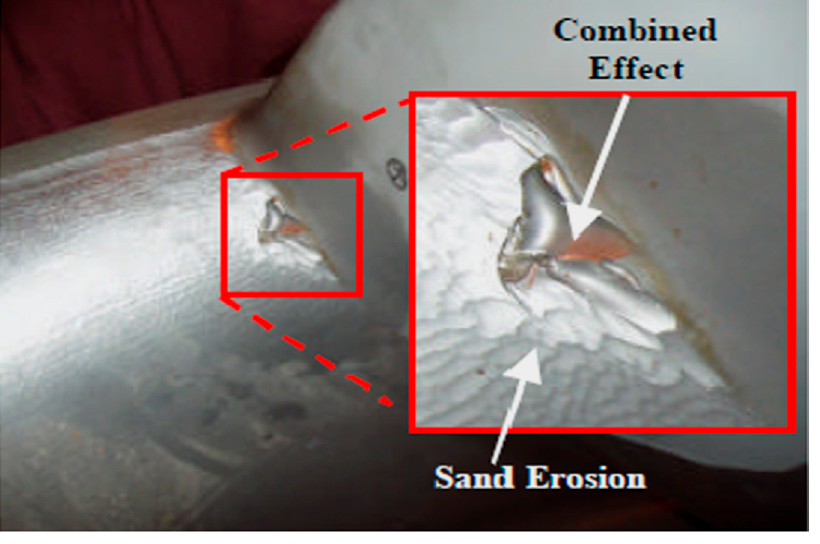
Figure 17. Damaged location of turbine runner with sand erosion and combined influence demar- cated.